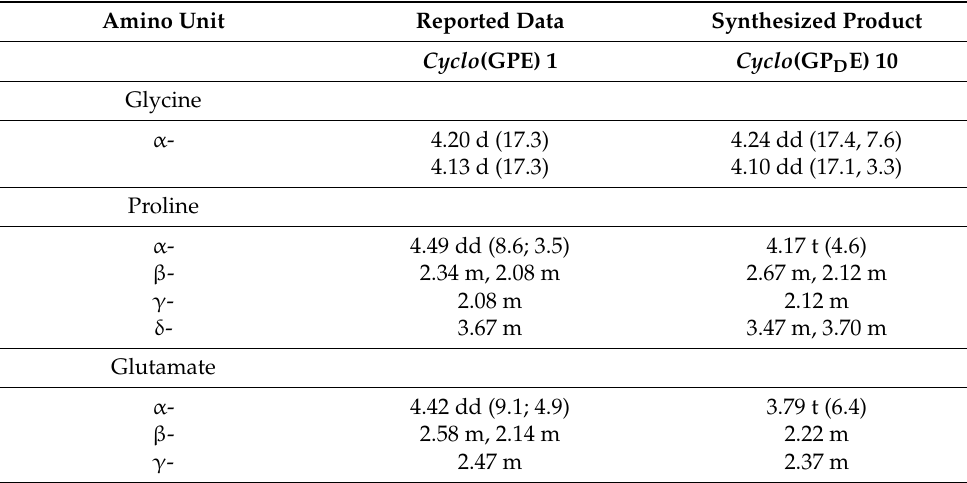
Table 4. 1 H-NMR data of cyclo (GPE) 1 [8] and cyclo (GP D E) 10 in D 2